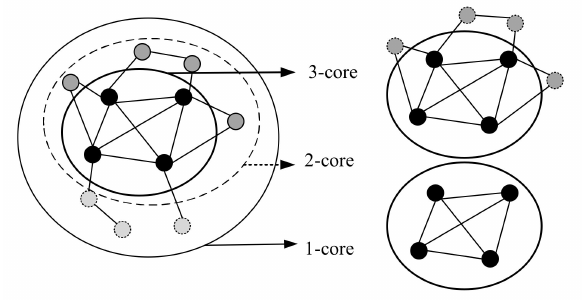
Figure 3. Process of generating K-subnets by